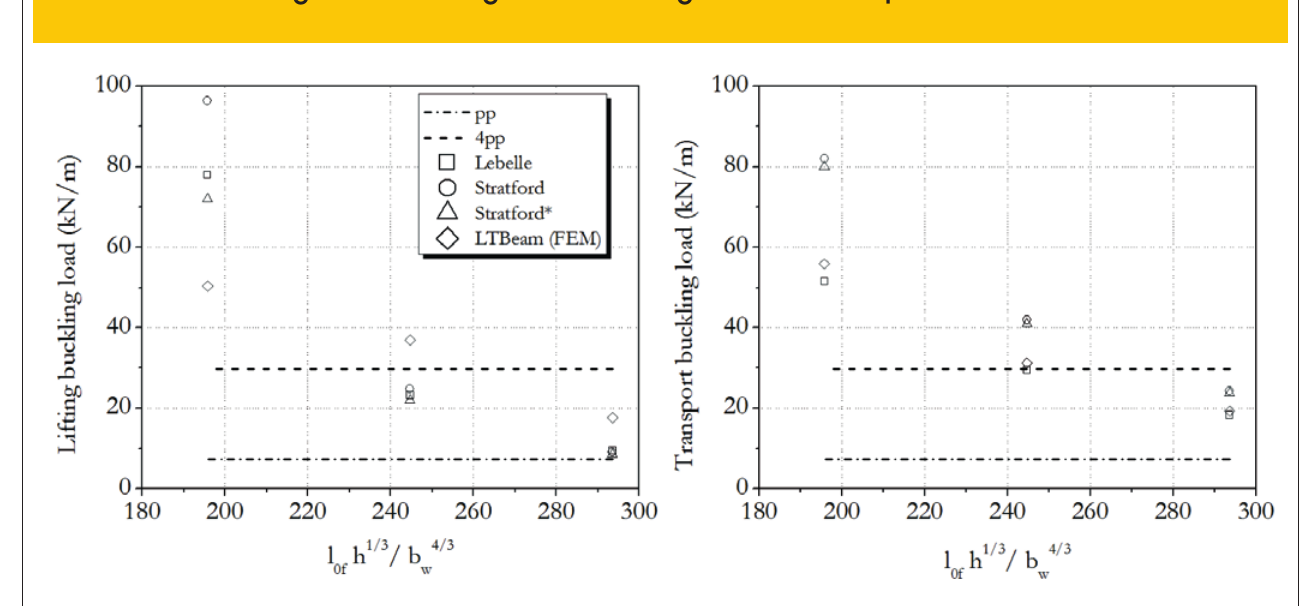
Figure 5 – Buckling load of rectangular beams for span variation